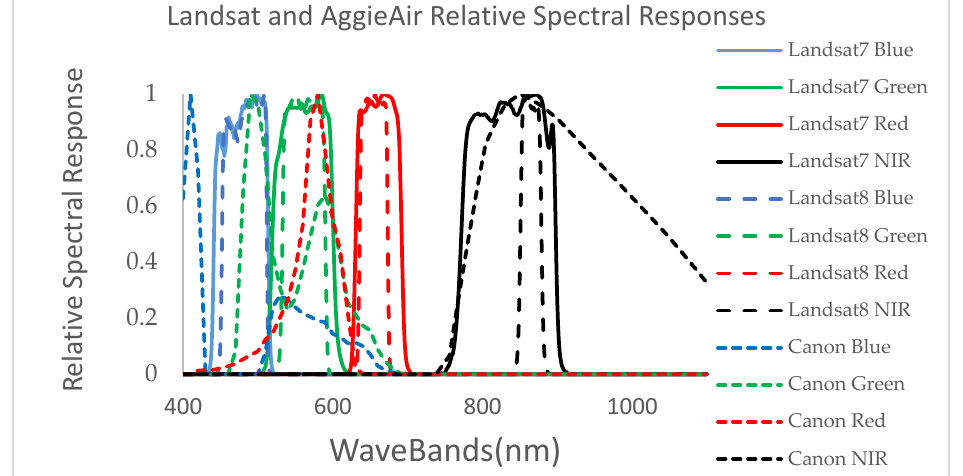
Figure 2. The spectral responses of AggieAir Canon cameras versus Landsat sensors (the spectral response is scaled for all individual bands from 0 to 1).